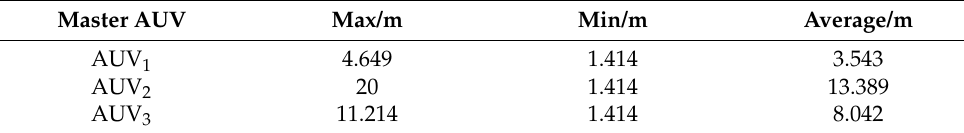
Table 4. Theoretical positioning errors of the AUVs.